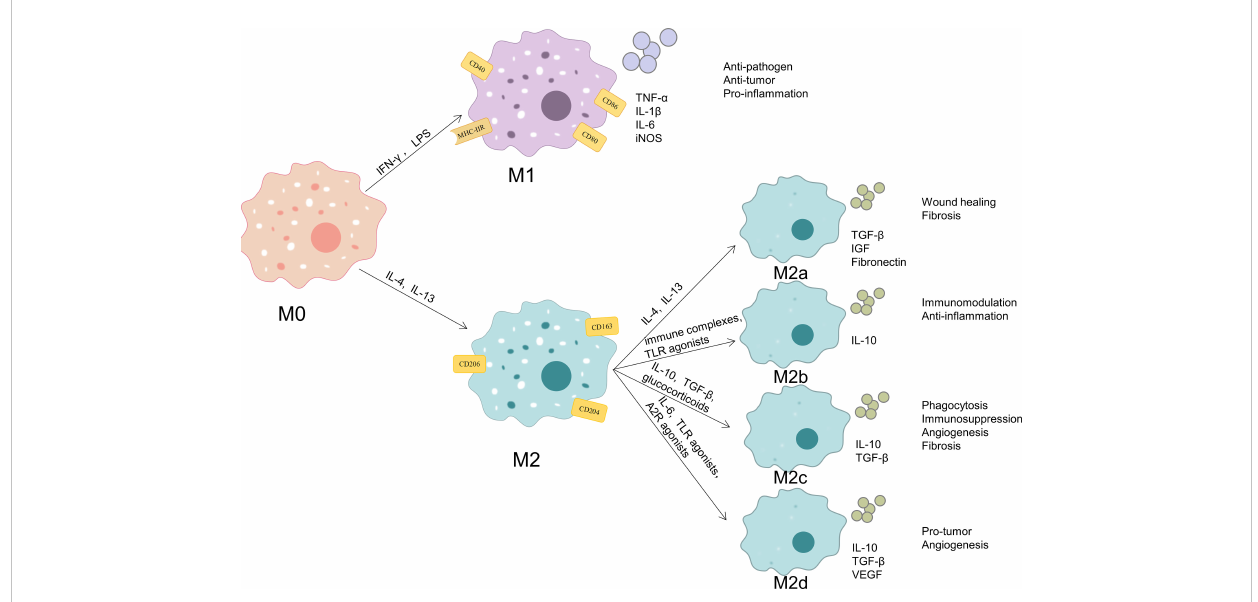
FIGURE 1 Phenotypes and functions of macrophage polarization. When exposed to different microenvironmental stimuli, M0 macrophages can be polarized into M1 macrophages and M2 macrophages. M2 macrophages can be subdivided into M2a, M2b, M2c and M2d. M1-type macrophages express the cell surface markers CD40, CD80, CD86, and MHC-IIR and release pro-in fl ammatory molecules such as TNF- a , IL-1 b , IL-6, and iNOS. These cells possess strong anti-pathogen, anti-tumor, and pro-in fl ammatory effects. M2-type macrophages express the cell surface markers CD163, CD204 and CD206. M2a macrophages secrete like TGF- b , IGF, and fi bronectin, and they can promote wound healing and fi brosis; M2b macrophages secrete IL-10, and they have strong immunomodulatory and anti-in fl ammatory effects;M2c macrophages secrete TGF- b and IL-10, and they exert phagocytosis, immunosuppression, angiogenesis, and development of tissue fi brosis;M2d macrophages secrete IL-10, TGF- b , and VEGF, and they promote angiogenesis and cancer